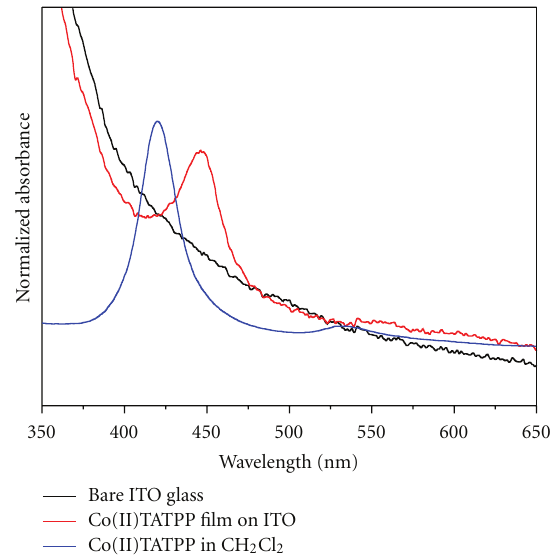
Figure 3: UV-visible absorption spectra of PANI-Co(II)TATPP electropolymer (membrane I.d) deposited on ITO glass slide. The spectra of Co(II)TATPP in CH 2 Cl 2 and bare ITO glass are given for